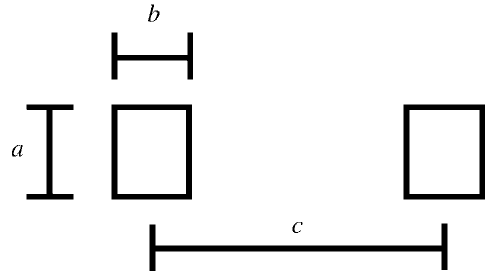
FIG. 4. The homemade cable for the twin-wire measure- ments. The dimensions are a (cid:2) 7 : 5 mm , b (cid:2) 5 mm , and c (cid:2) 40 : 6 mm .